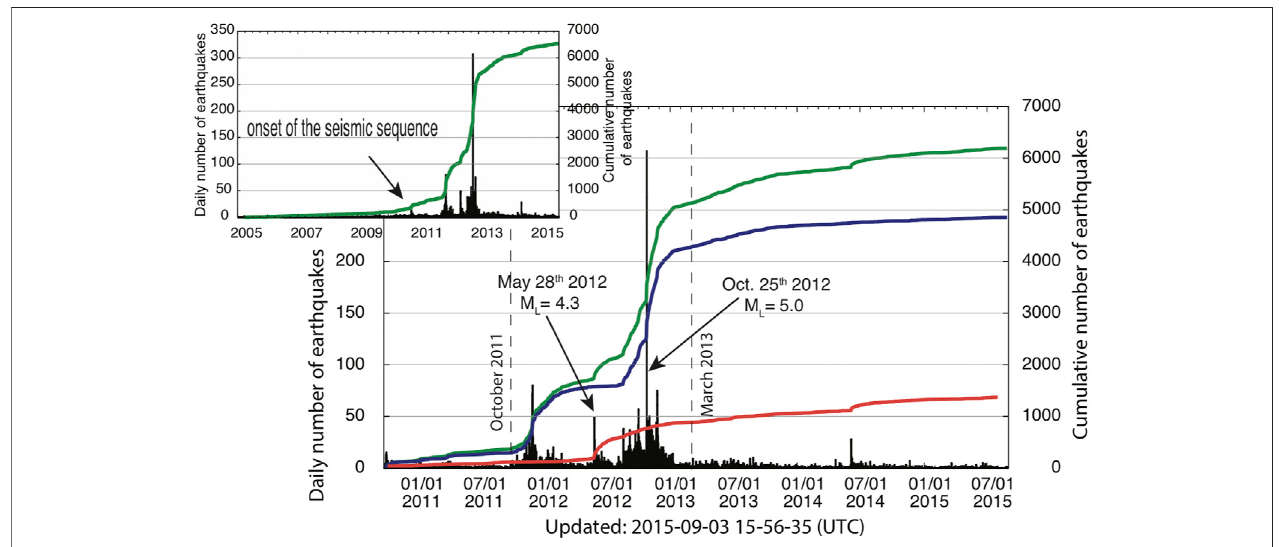
FIGURE 3 | Temporal evolution of the swarm: black histogram de fi nes the daily number of events, the green line is the cumulative number of events in the whole region, the blue line and the red line are the cumulative number of events for the western and eastern cluster, respectively. Only the blue line trend seems to follow a mainshock – aftershock behavior.